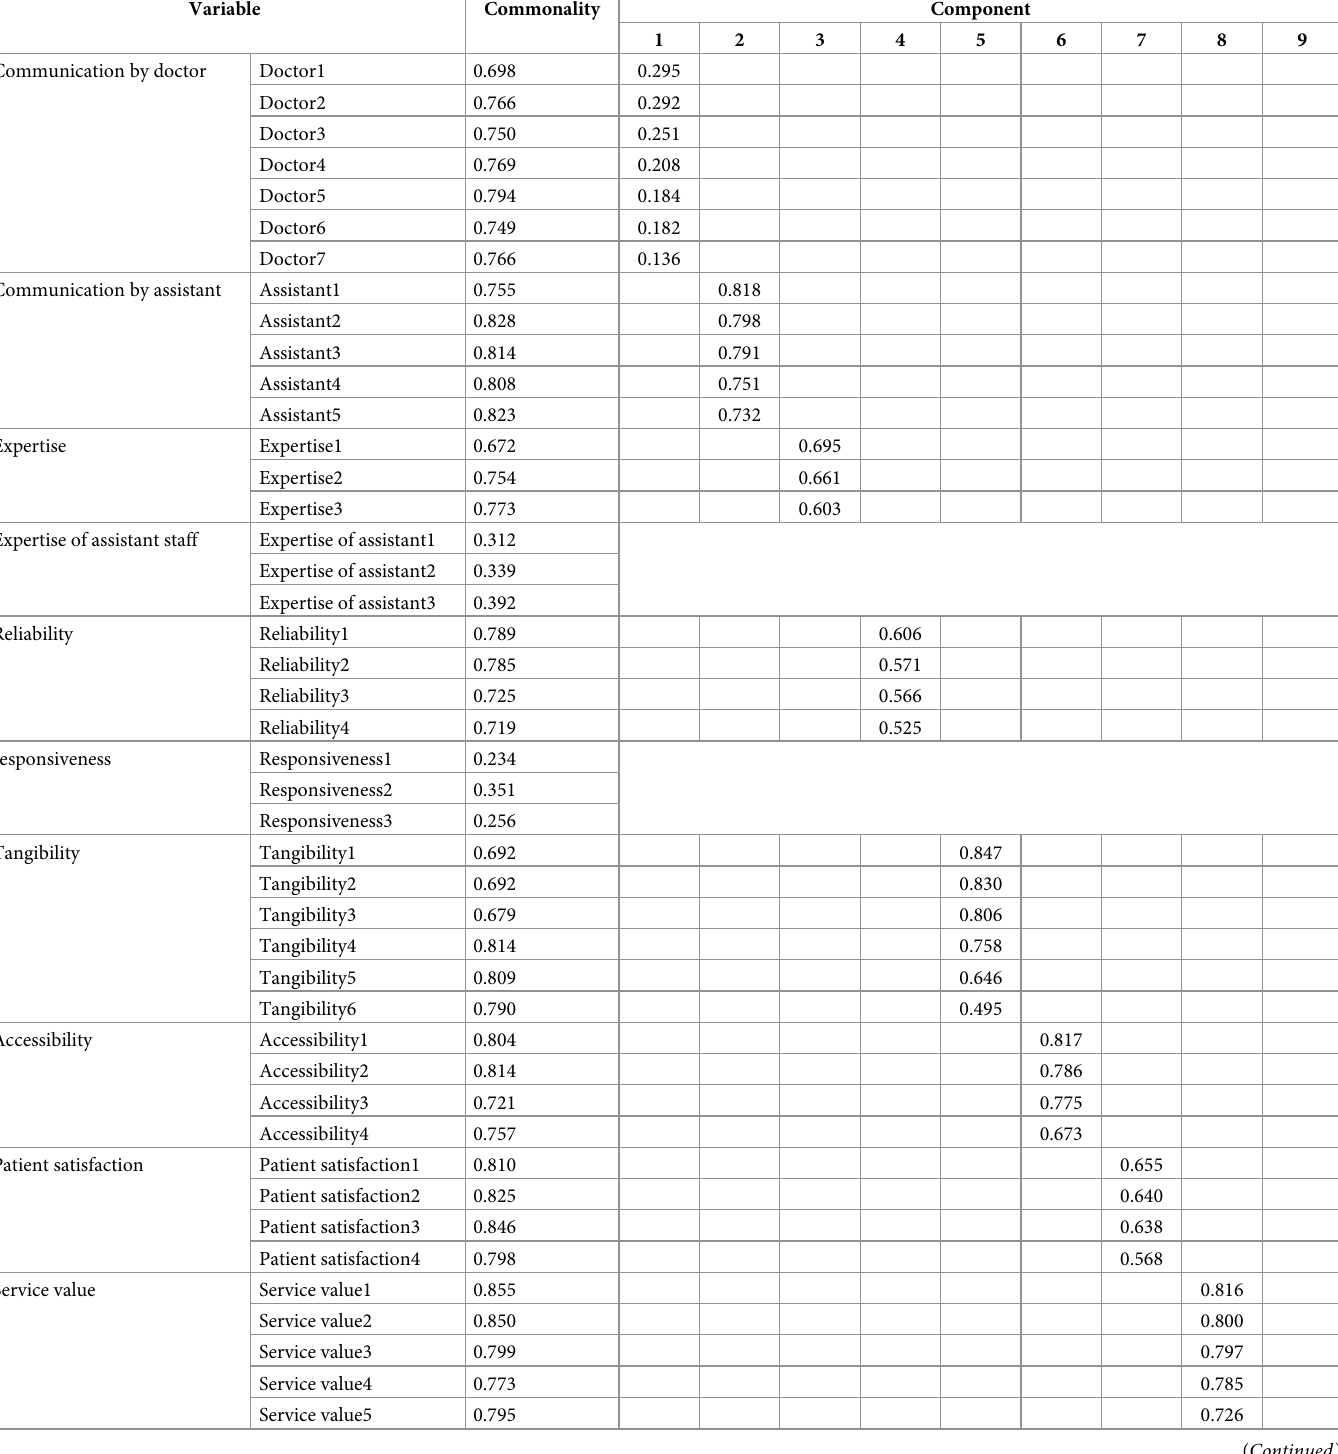
Table 2. EFA results.